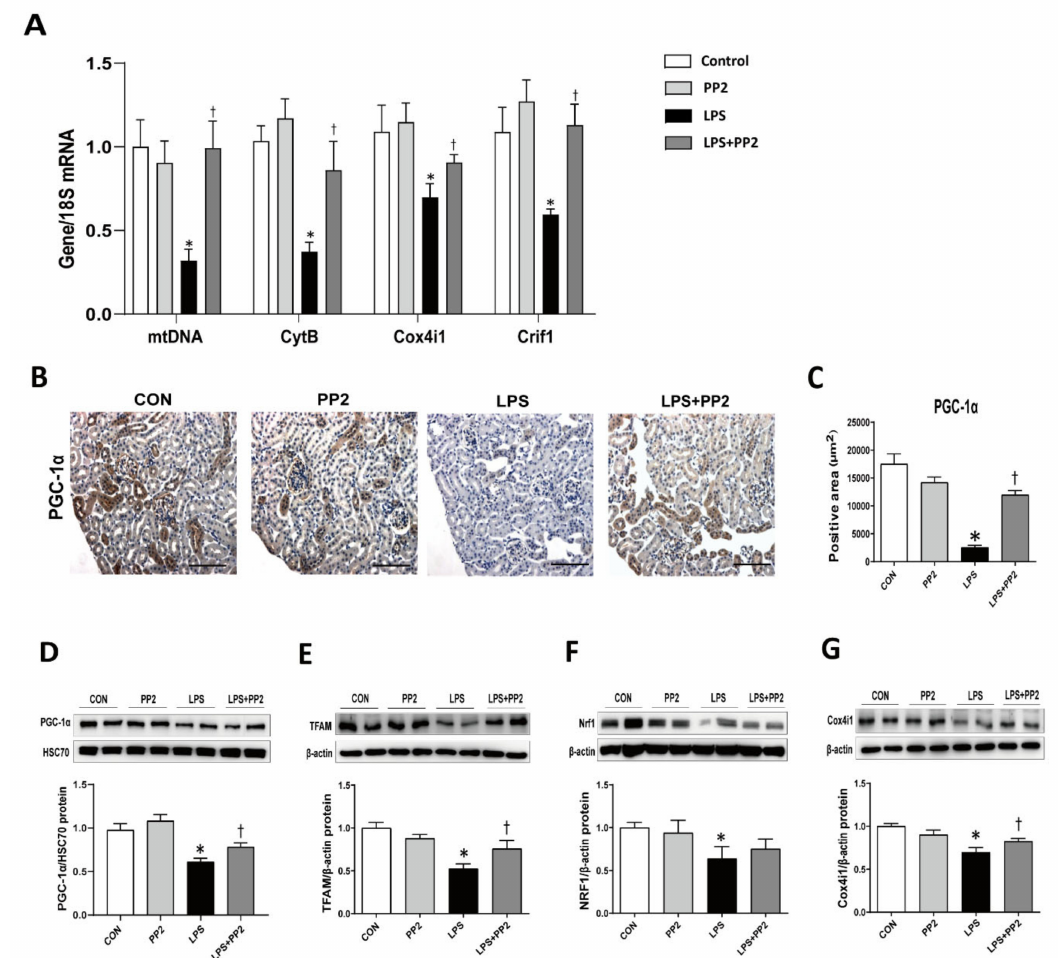
Figure 7. PP2 preserves mitochondrial biogenesis in LPS-induced AKI mice. ( A – G ) Six-week-old male C57 / BL6 mice were pretreated with PP2 (2 mg / kg) for 2 h and then administered LPS (15 mg / kg) for 18 h. ( A ) The mRNA levels of mtDNA, CytB, Cox4i1, and Crif1 in kidney tissue were measured using real time RT-PCR analysis. The levels of mRNA were normalized with 18S. ( B – C ) Para ffi n-embedded kidney sections were stained with PGC-1 α antibody (1:200; original magnification: 200 × ; scale bar: 100 µ m). Immunoblotting analysis of ( D ) PGC-1 α , ( E ) TFAM, ( F ) Nrf1, and ( G ) Cox4i1 in the kidney was performed. The levels of proteins were normalized with HSC70 and β -actin. Data are presented as mean ± SE of 6–8 mice * p < 0.05 vs. control, † p < 0.05 vs.